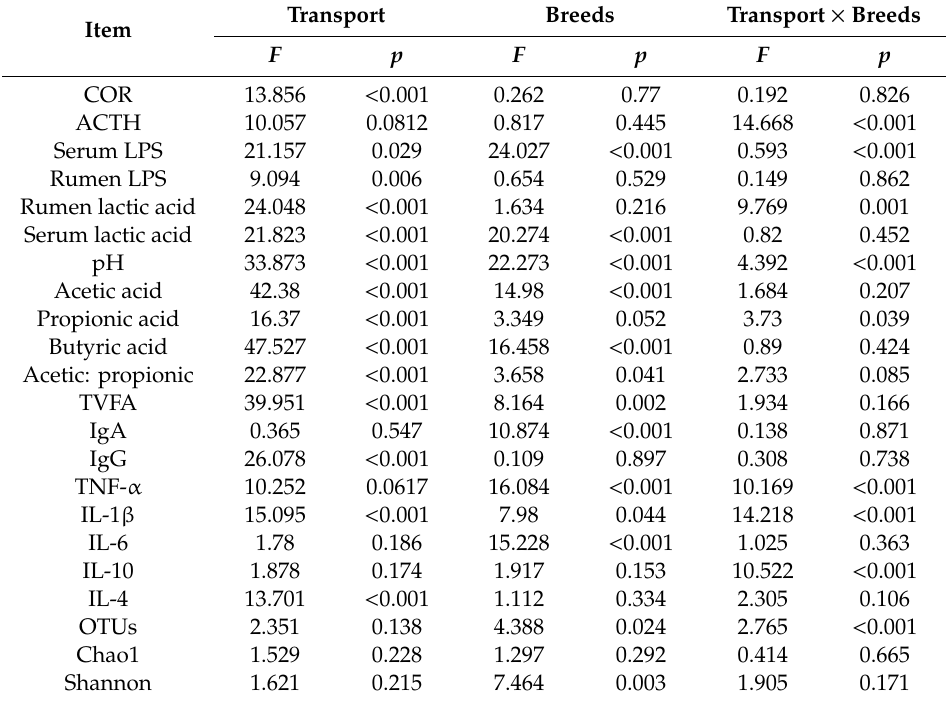
Table 5. Two-way analysis of transportation stress and beef